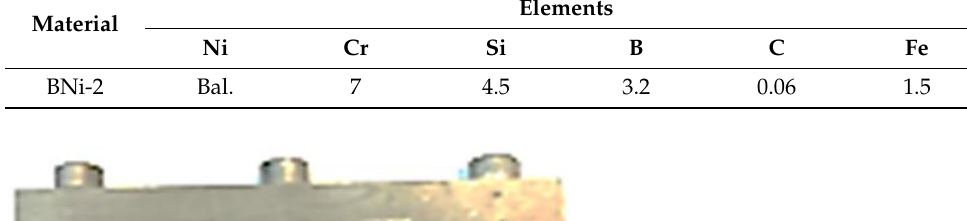
Table 2. Chemical composition of nickel-based BNi-9 amorphous foil (wt.%). Material